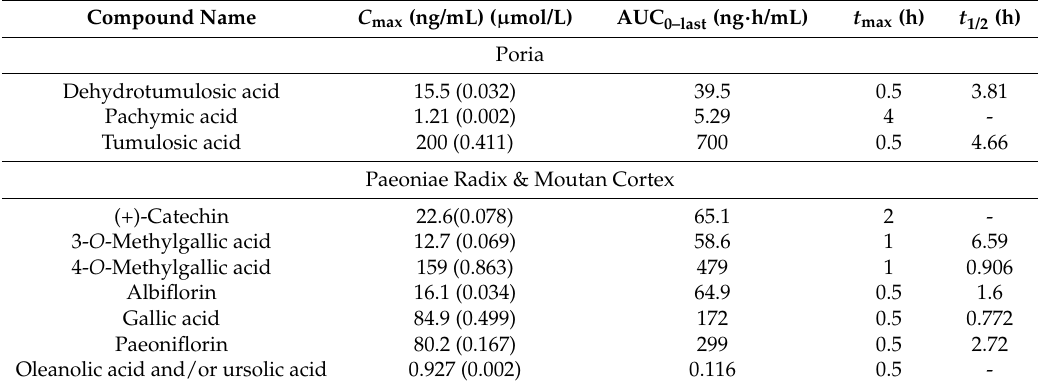
Table 2. Pharmacokinetic parameters of KBGY constituents identified in the plasma of rats treated with KBGY.